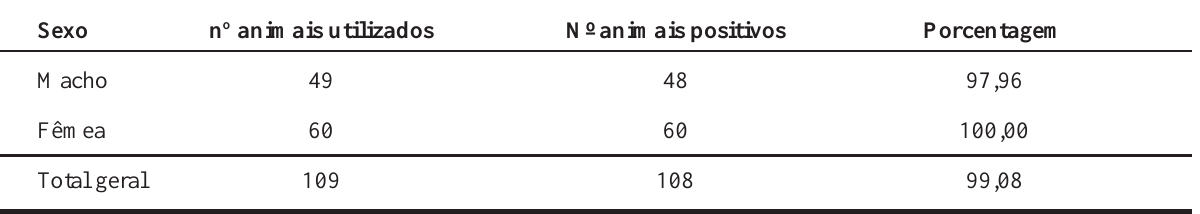
TABELA 1 - Distribuição dos animais pelo sexo, com positividade para Helicobacter pelo teste rápido da urease e porcentagem correspondente.